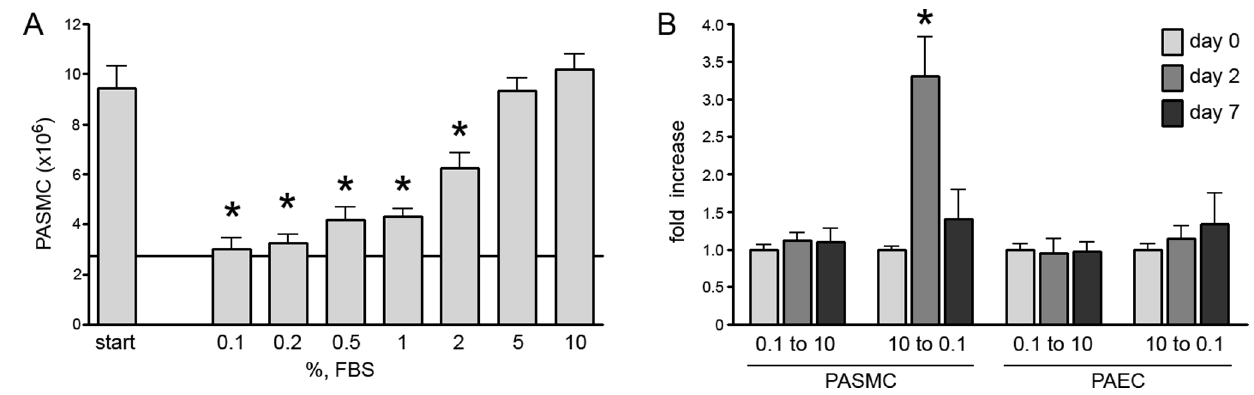
Figure 7. PASMC that attain confluence at high serum cannot maintain that cell density in low serum. Human PASMC were grown to confluence in 10% FBS and maintained in 10% serum for 7 days. Confluence was determined by light microscopy and by the demonstration of stable cell number over 7 days. Cells were then exposed to various concentrations of serum ranging from 0.1% to 10%: A) Cell counts done 7 days later. B) Cells were stained with the membrane impermeable dye ethidium homodimer-1 at different time points to determine cell viability. Ethidium homodimer-1 can only stain apoptotic or necrotic cells and is a marker of cell death. Cell death is increased by day 2 and returns to baseline by day 7. (n=3 separate experiments, * indicates p , .05 compared with starting cell number for (A) or compared to day 0 at 10% serum for